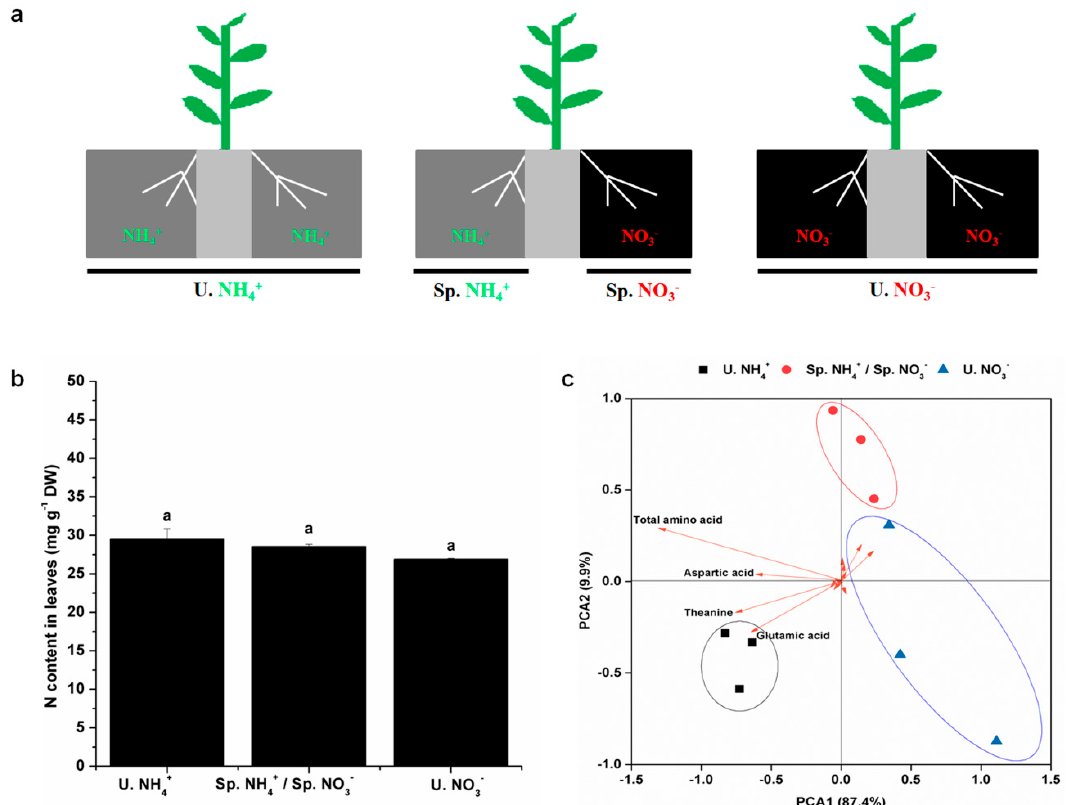
Figure 1. Nitrogen (N) content and diversity of free amino acids (FAAs) in leaves under the split-root system. ( a ) Diagram showing the split-root system used to simulate the spatial heterogeneity of different N forms. Two separated physical spaces where different N forms could be applied, were created in this split-root system: U. ammonium (NH 4+ ) (both compartments had NH 4+ ), U. nitrate (NO 3 − ) (both compartments had NO 3 − ), Sp. NH 4+ (one of the compartments had NH 4+ ), and Sp. NO 3 − (the other compartment had NO 3 − ); ( b ) leaf N content; ( c ) diversity of FAAs in the leaves. The mean ± SE ( n = 3) are shown in the data. The different letters show that means are significantly different at p < 0.05. The different conditions to compare the analytical results obtained are shown in the Materials and Methods section.